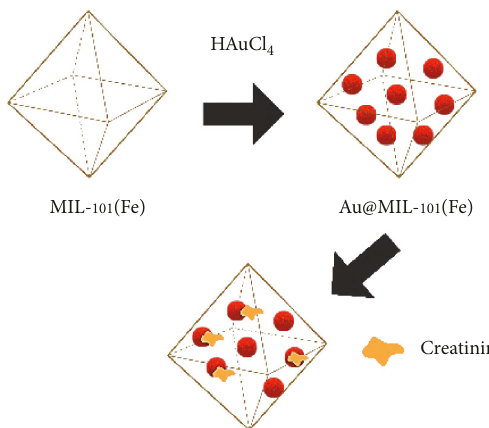
Figure 3: The schematic in-situ construction and the creatinine capturing mechanism of